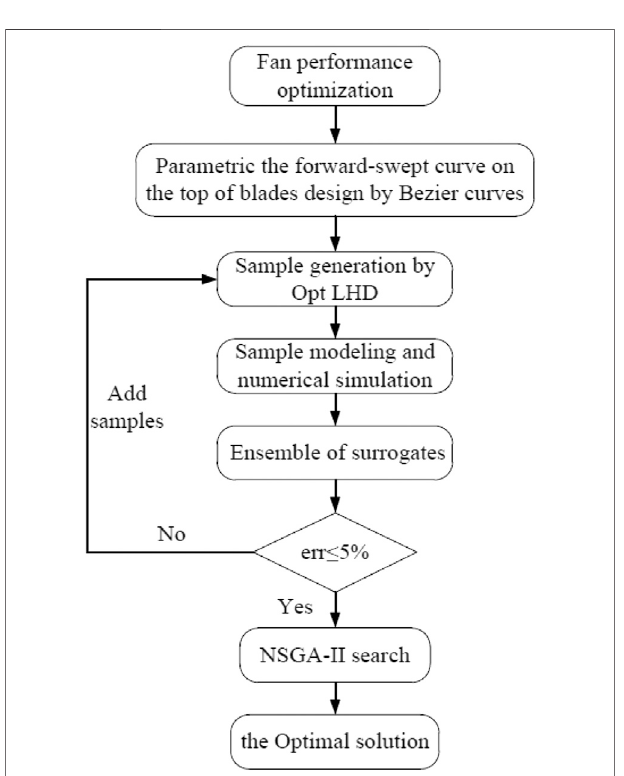
FIGURE 13 | Optimization